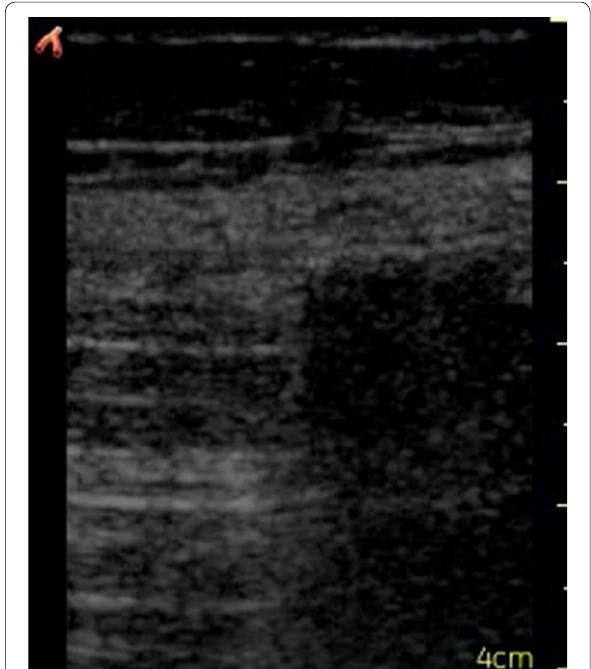
Fig. 1 The “gut point” is the transition zone between normal bowel artifact, that may normally contain A-lines, and the abnormal A-line pattern without sliding. Similar to pneumothorax, an absence of sliding with the presence of A-lines is a diagnostic indicator